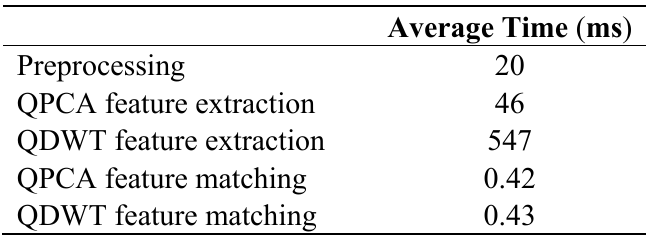
Table 4. Execution